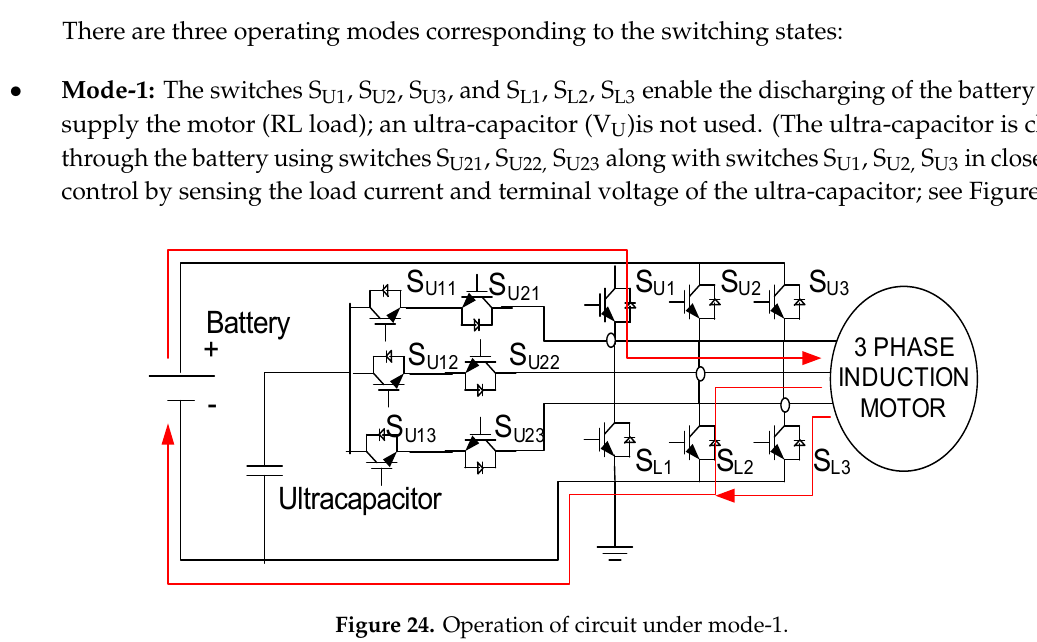
Figure 25. Operation of circuit under mode-2. The phase voltages (V 1O , V 2O , V 3O ) are functions of the state of the switches and input voltages: V 1O =